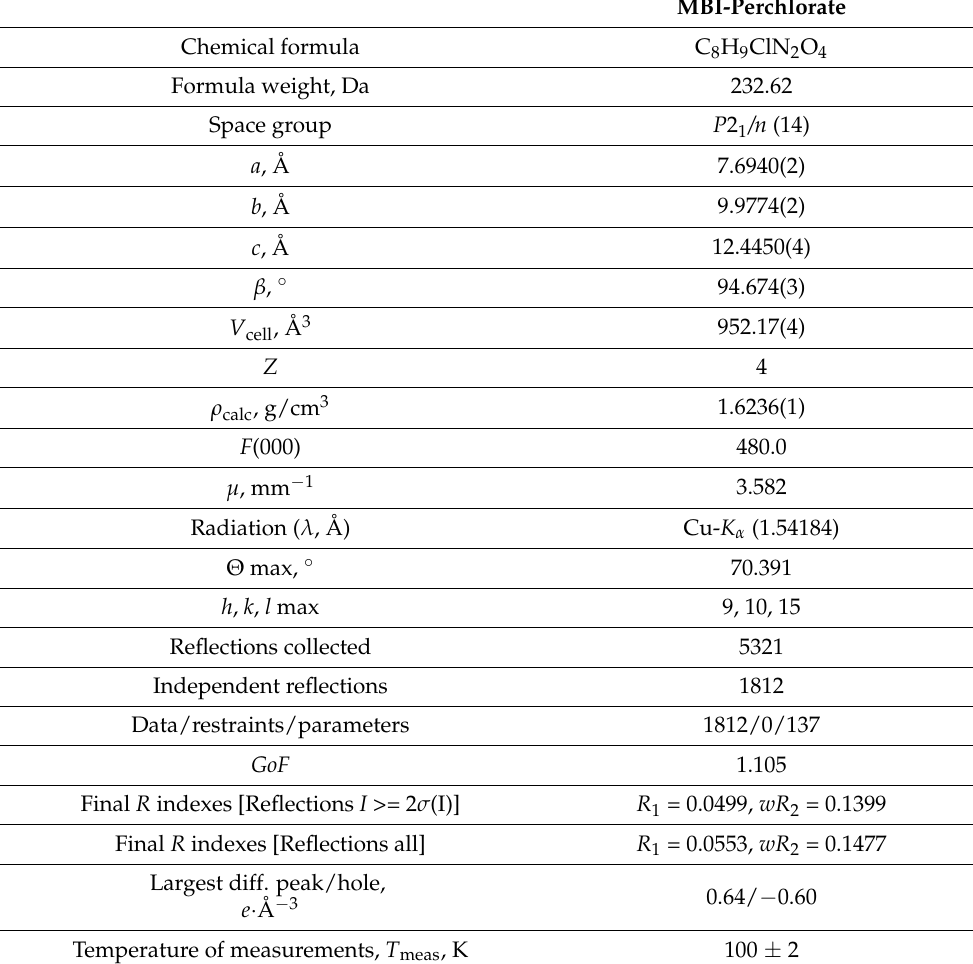
Table 1. Details of crystal data and structure refinement of MBI-perchlorate single crystal (Sample